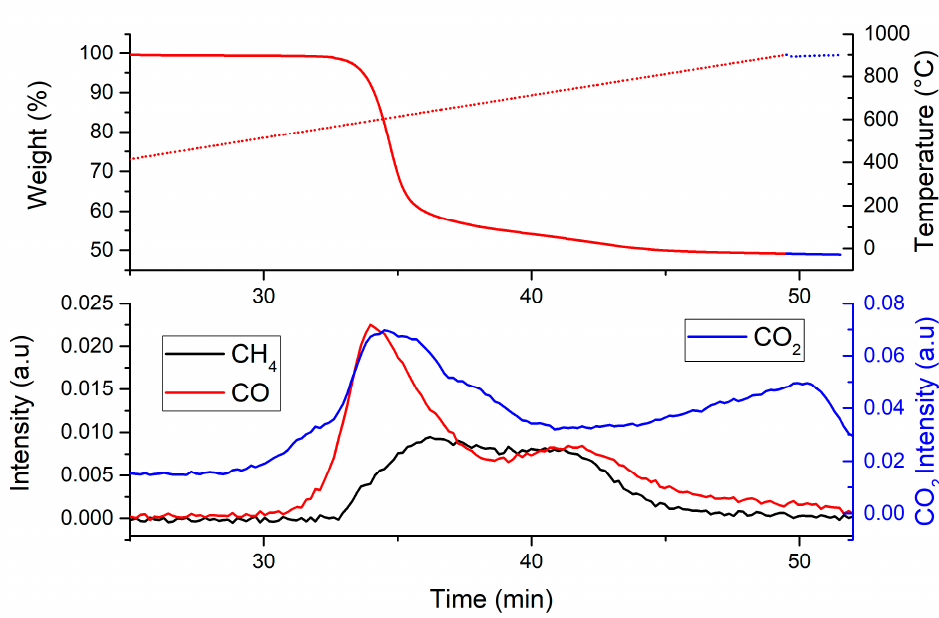
Figure 4. TGA curve of PEEK under nitrogen at a heating rate of 20 °C/min ( top ) and intensity profiles of characteristic peaks of CO (2184 cm − 1 ), CO 2 (2356 cm − 1) and CH 4 (3018 cm − 1 ) obtained through FTIR ( bottom ).